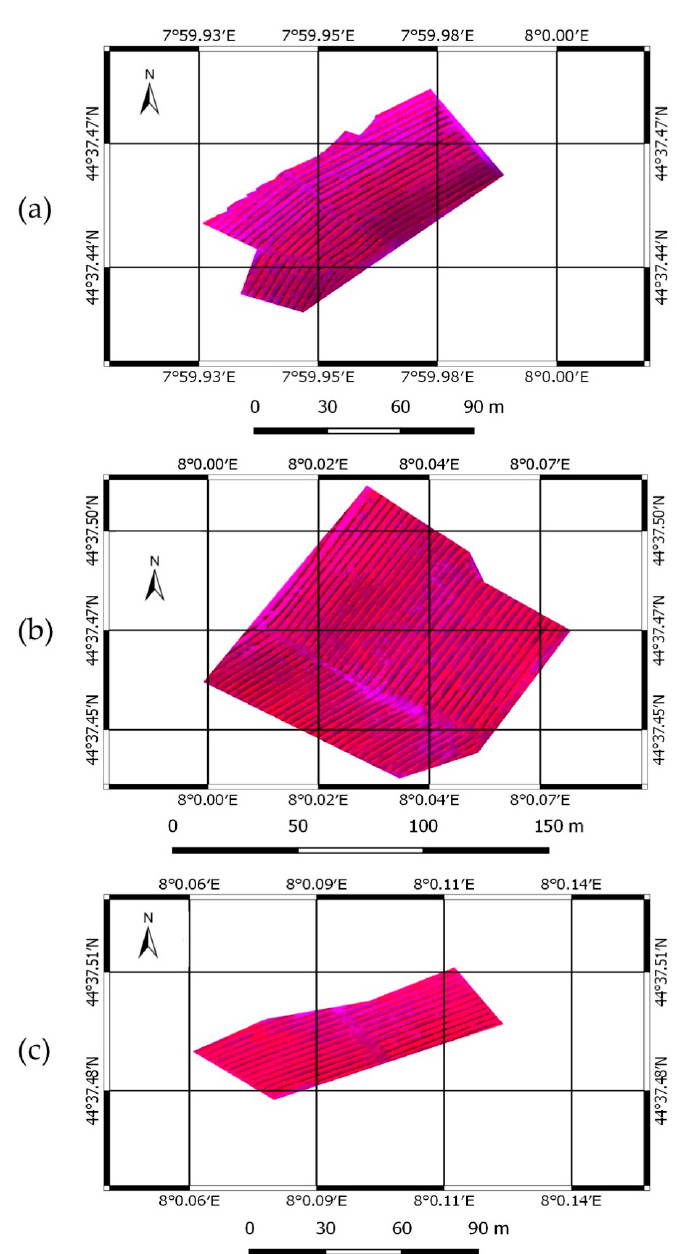
Figure 2. Enlargement of UAV-based multispectral imagery, represented in false colours (NIR, Red and Green channels), of: ( a ): “Parcel-A”; ( b ): ”Parcel-B”; and ( c ): “Parcel-C”.